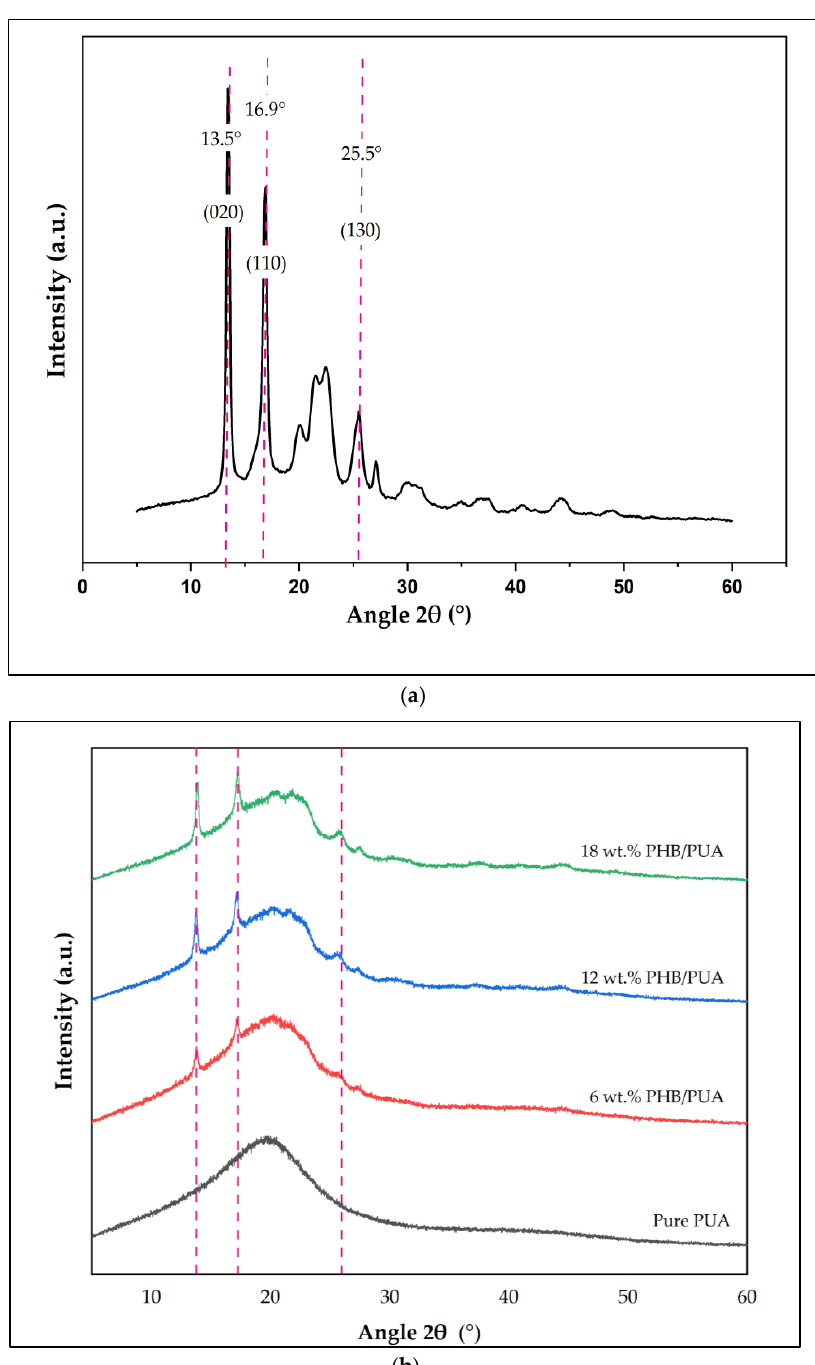
Figure 6. X-ray diffraction patterns: ( a ) PHB powder; ( b ) 3D-printed PUA and 3D-printed PHB/PUA. Table 4. Crystallinity Index (CI) for PHB powder and 3D-printed PHB/PUA. Weight Composition